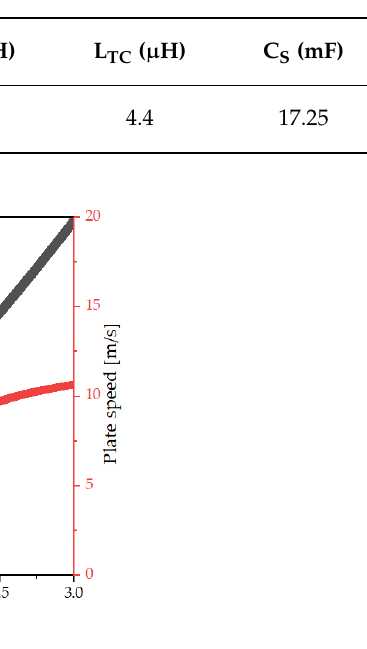
Figure 7. Simulation of current changes due to system inductance and network inductance simula- Table 2. Thomson coil operating circuit parameters.